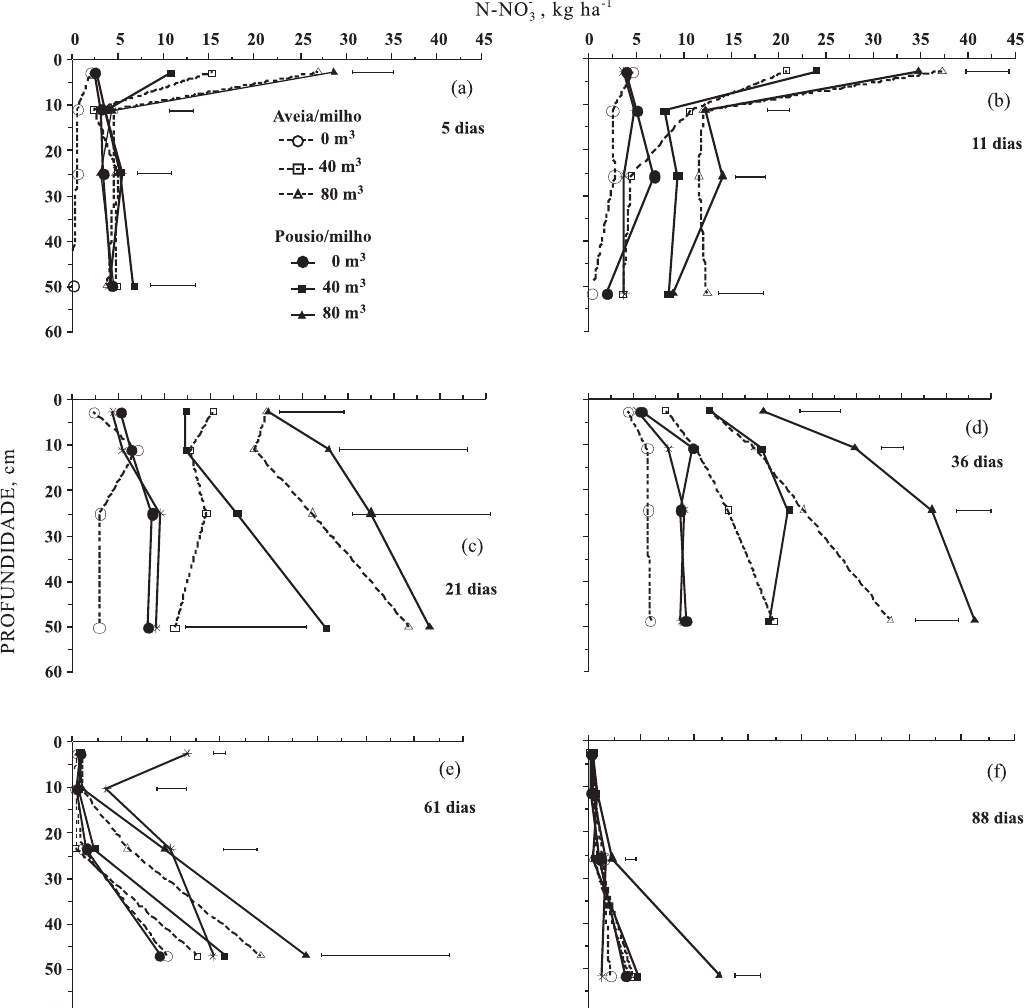
Figura 3. Quantidades de N-NO 3- na camada de 0–60 cm do solo durante o cultivo de milho, aos 5, 11, 21, 36, 61 e 88 dias após a aplicação dos dejetos (0, 40 e 80 m 3 ha -1 ), nos sistemas aveia/milho e pousio/milho e uréia no sistema pousio/milho nos três anos agrícolas (1998/99, 1999/00 e 2000/01). Nas profundidades em que existem barras horizontais, estas indicam diferença mínima significativa (Tukey a 5